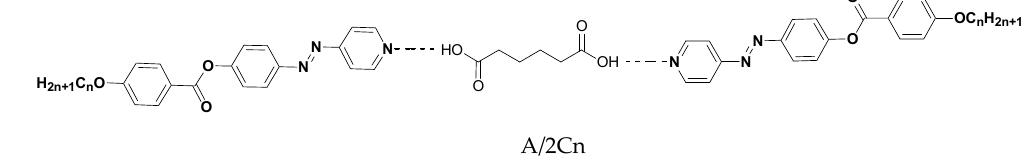
Figure 6. 1:2 HBSMCs A/2Cn [34].